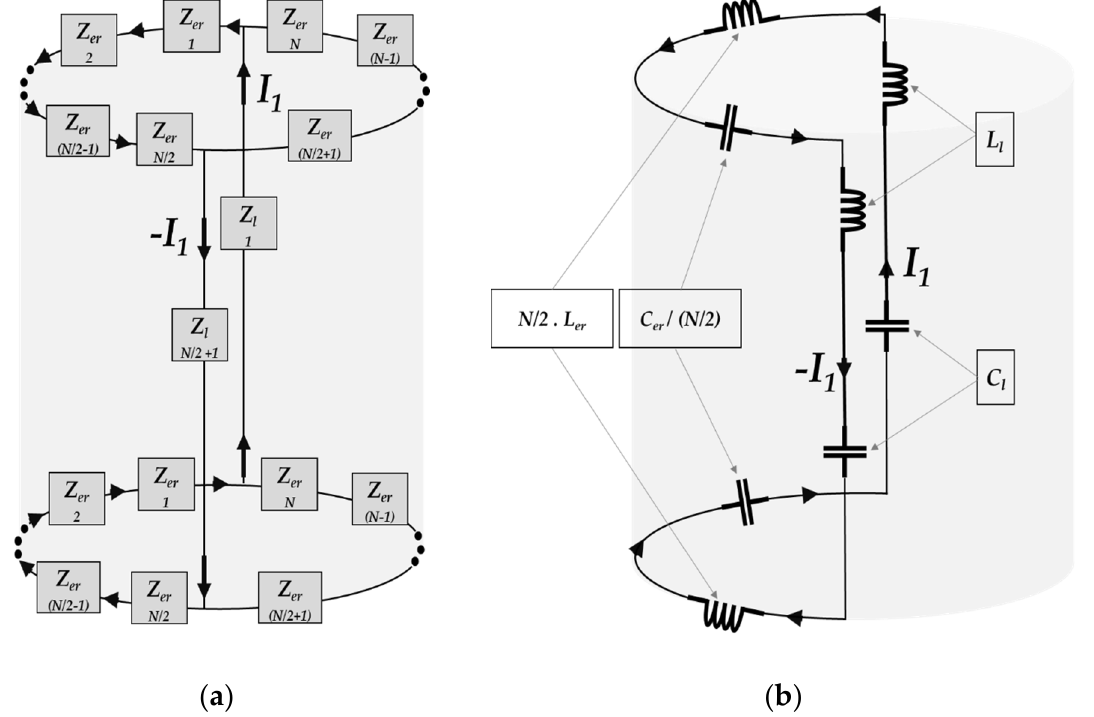
Figure 4. A closed current loop in the birdcage RF coil representing: ( a ) The dominant resonance path; ( b ) Total lumped inductance and capacitance of end-rings and legs in the dominant resonance path. There exists total N/2 closed current loops of path length P in birdcage RF coil. Any leg of the